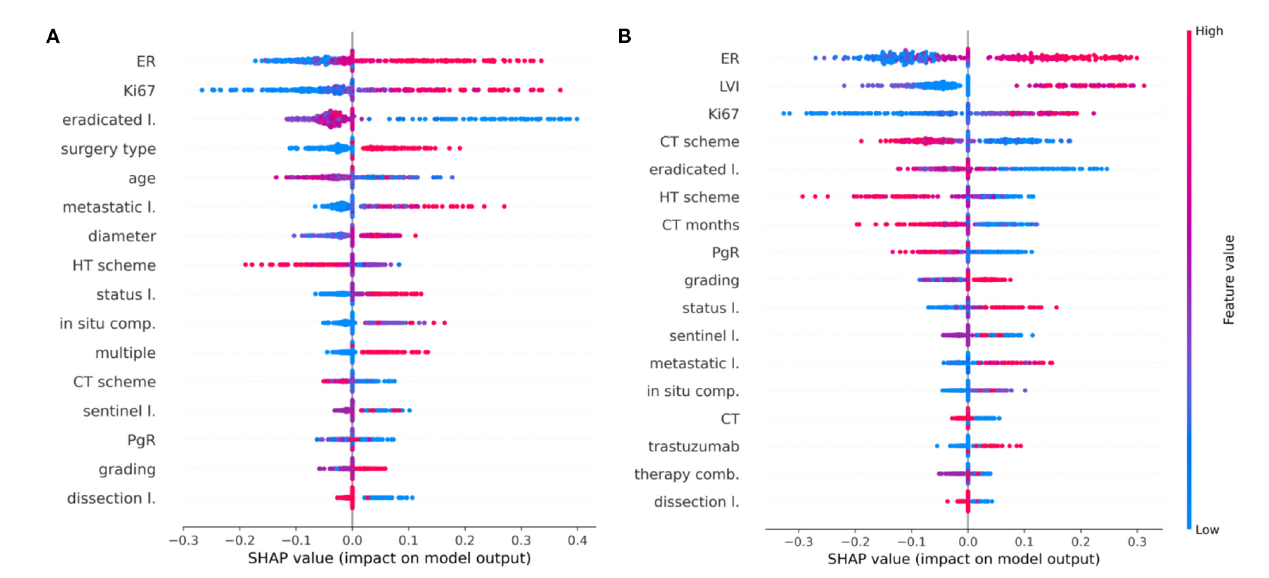
FIGURE5 Shapley value distributions. Combination of feature importance with feature effects for (A) the 5-year IDE predictive model and (B) the 10-year IDE predictive model. Each point on the plot is a Shapley value for a feature and a patient. The color bar represents the value of the feature from low (in blue) to high (in red) for that instance. Integer values associated with categorical variables obey the following rules: in situ component (0, not present; 1, present, not typed; 2, G1; 3, G2; 4, G3), LVI (0, not present; 1, present, not typed; 2, focal; 3, extended), sentinel lymph node (0, negative; 1, not done; 2, positive), surgery type (1, quadrantectomy; 2, mastectomy), CT scheme (0, absent; 1, anthracycline + taxanes; 2, antracycline; 3, taxanes; 4, CMF; 5, other), HT scheme (0, absent; 1, Tamoxifen; 2, LHRHa; 3, Tamoxifen + LHRHa; 4, Aromatase Inhibitors; 5, Tamoxifen + Aromatase Inhibitors; 6, LHRHa + Aromatase Inhibitors; 7, other), therapy combination (0, No; 1, HT; 2, CT; 3, CT + HT, 4, CT + trastuzumab, 5, CT + HT + trastuzumab).